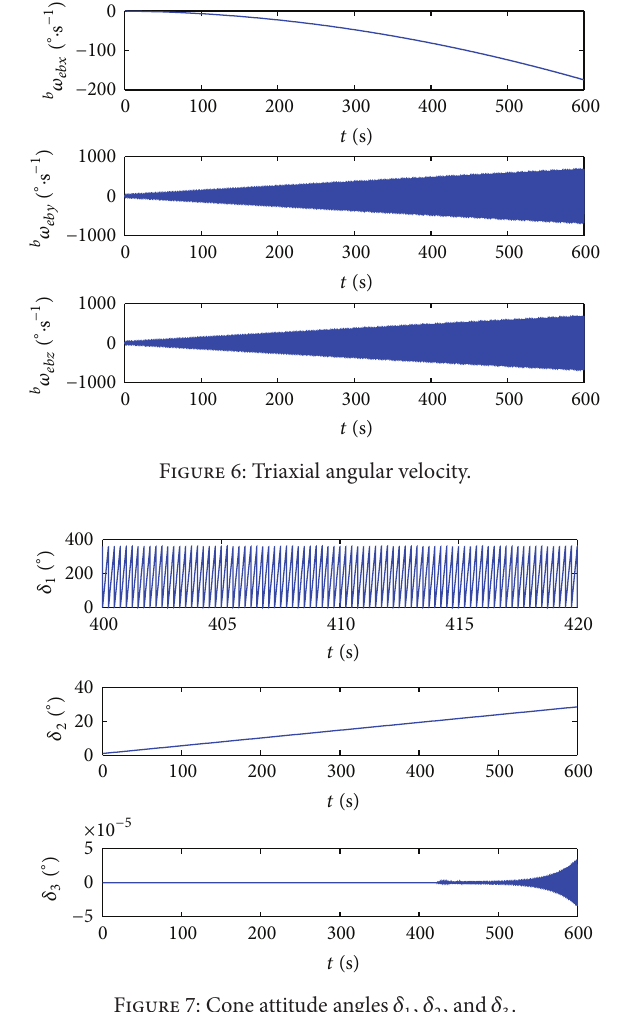
Figure 7: Cone attitude angles 𝛿 1 , 𝛿 2 , and 𝛿 3